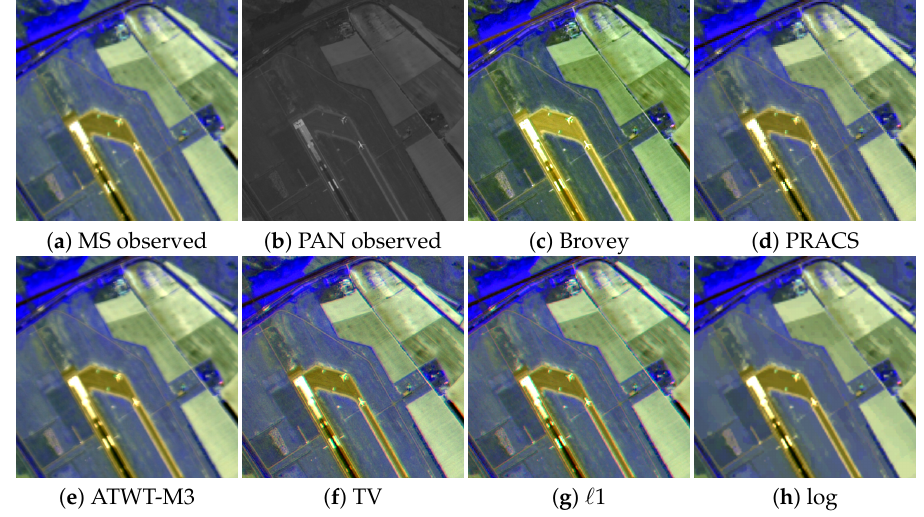
Figure 8. A region of interest of the SPOT-5 Roma image in Figure 3a. Observed images: ( a ) 128 × 128 MS, ( b ) 512 × 512 PAN. 512 × 512 pansharpened images by: ( c ) Brovey, ( d ) PRACS, ( e ) Additive A Trous Wavelet Transform (ATWT)-M3, ( f ) TV, ( g ) (cid:96) 1 and ( h ) log